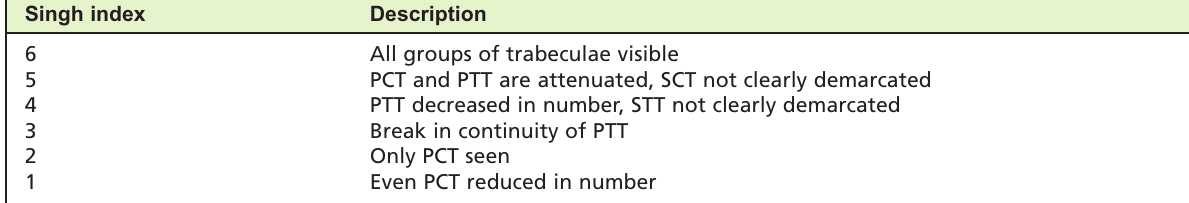
Singh index grading and its corresponding radiological description on radiographs Table I: